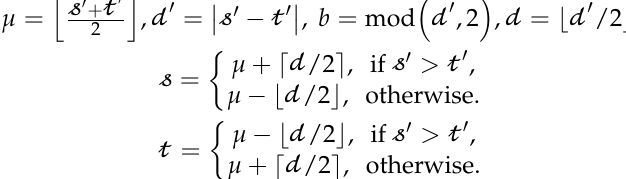
Algorithm 2 Data Embedding for Complex Blocks